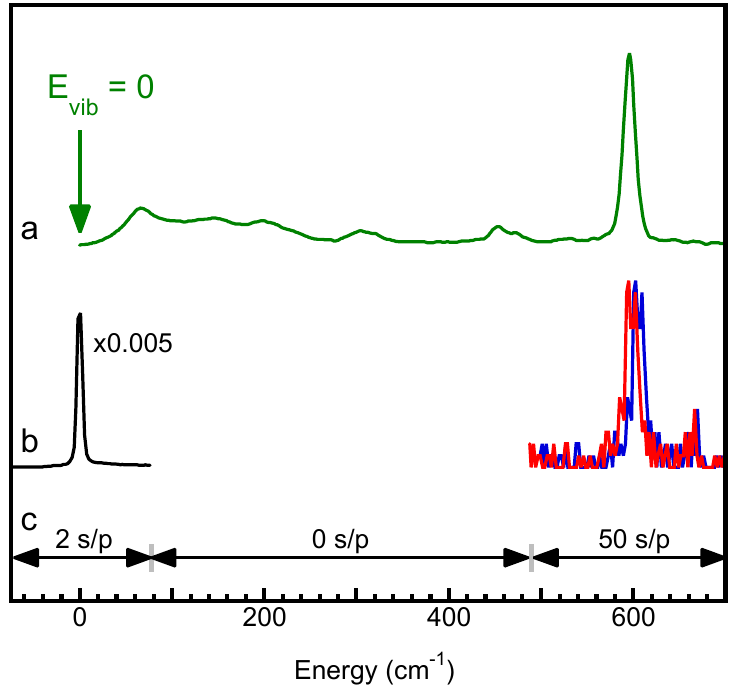
Figure 7. The NRVS spectra for a series of Fe(CN) 6 containing complexes: ( a ) PVDOS for (NH 4 ) 2 MgFe(CN) 6 ; ( b ) raw NRVS spectrum for KEuFe(CN) 6 which was measured with a jump scan procedure around the Fe(CN) region and the nuclear resonant peak region. The blue spectrum was calibrated with the tradition procedure (1) and the red one is re-calibrated with a time-based proce- dure using (2); and ( c ) the scanning time per point (s/p) used in different energy regions during the NRVS measurement for KEuFe(CN) 6 ( b ).